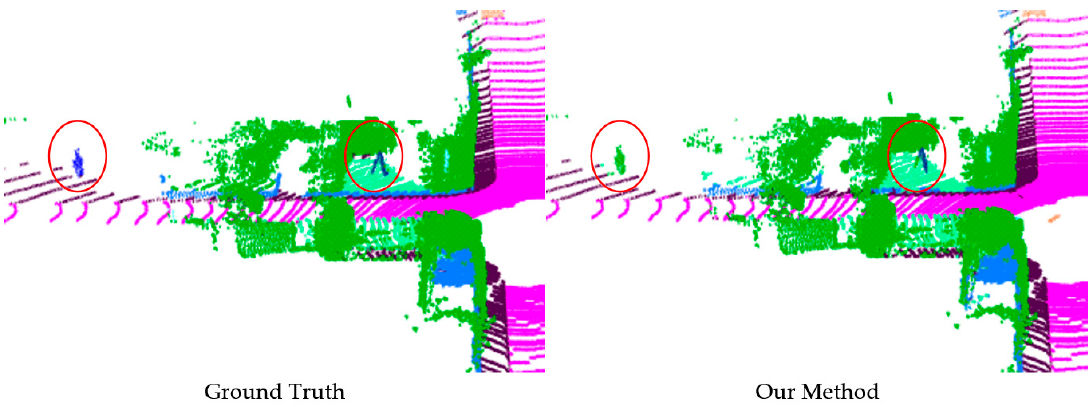
Figure 9. A false segmentation case of person and trunks.